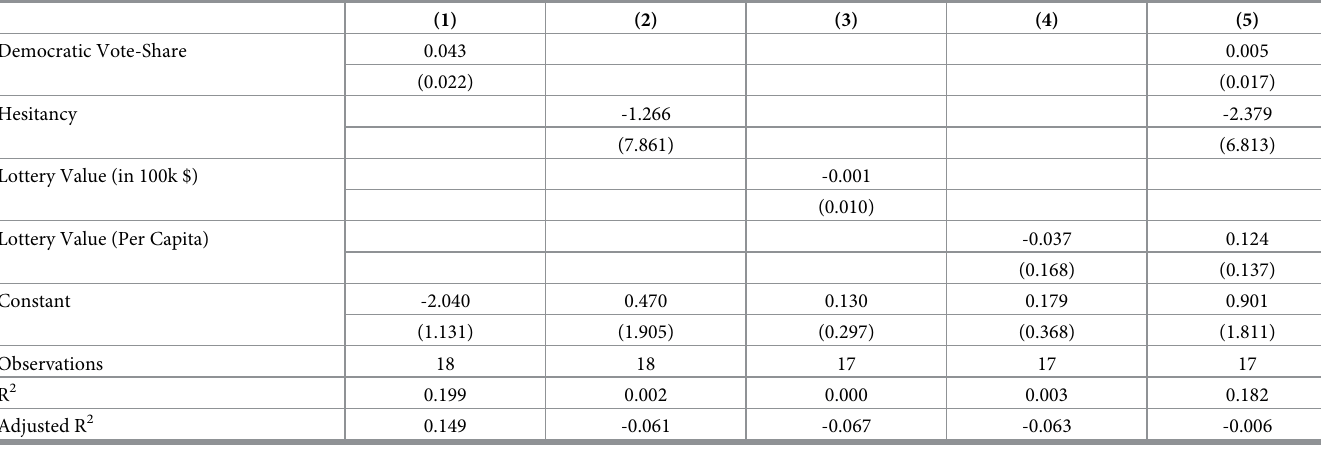
Table 2. TADD explanatory regression results